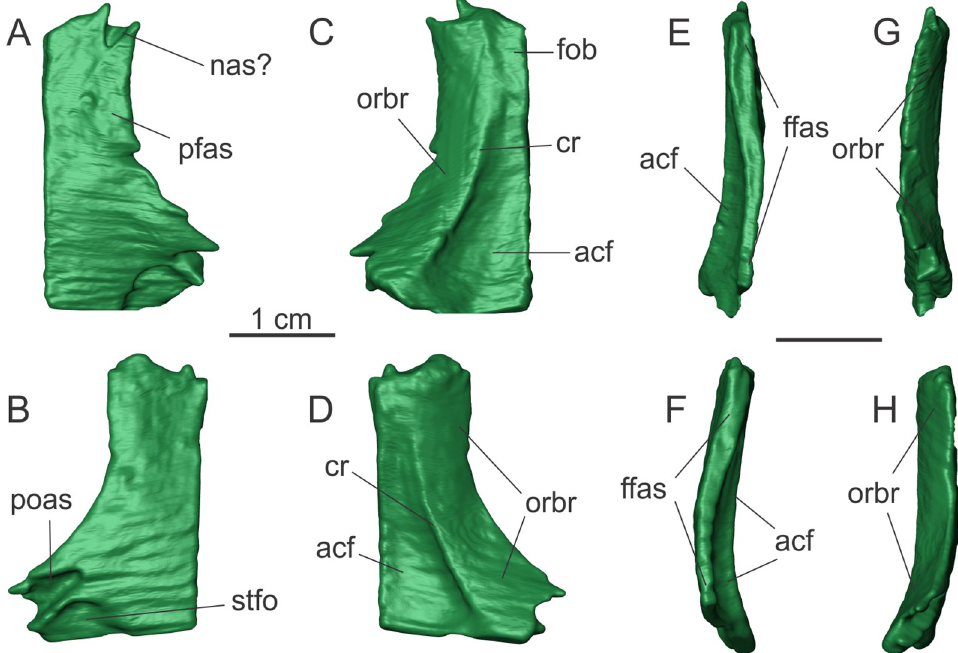
Fig 2. Right and left frontals of the specimen MCP 3845 PV of Saturnalia tupiniquim in dorsal (A, B), ventral (C, D), medial (E, F), and lateral (G, H) views, respectively. Abbreviations: acf— anterior cranial fossa; cr— crest; ffas— frontal/frontal articulation surface; fob— fossa for the olfactory bulb; nas —articulation surface with the nasal; orbr— orbital roof; pfas— articulation surface with the prefrontal; poas— articulation surface with the postorbital; stfo— supratemporal